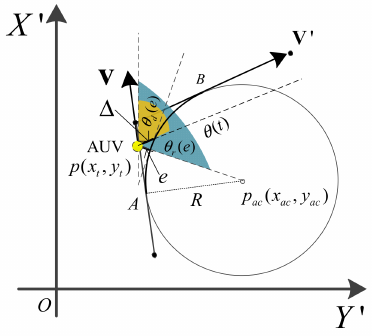
Figure 2. Line-of-sight guidance for AUV trajectory.